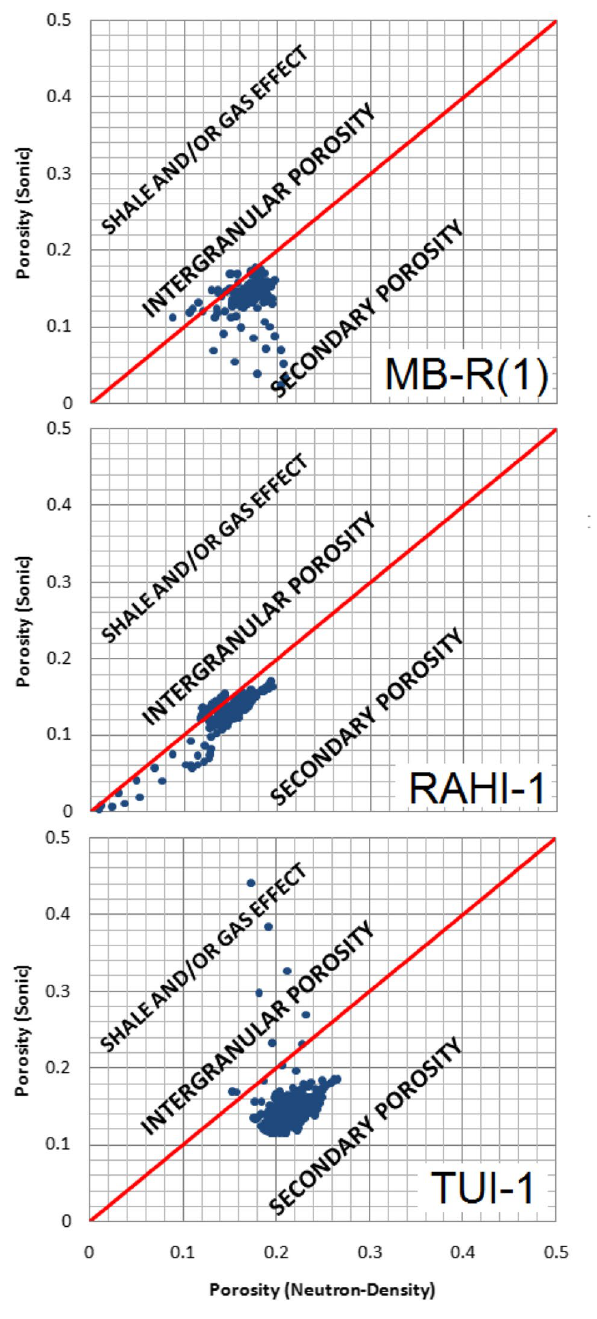
Fig. 11 Total porosity type for the Farewell Formation sandstones MB-R(1) Well log interpretation showing three pay zones with Zone 3 as the most promising